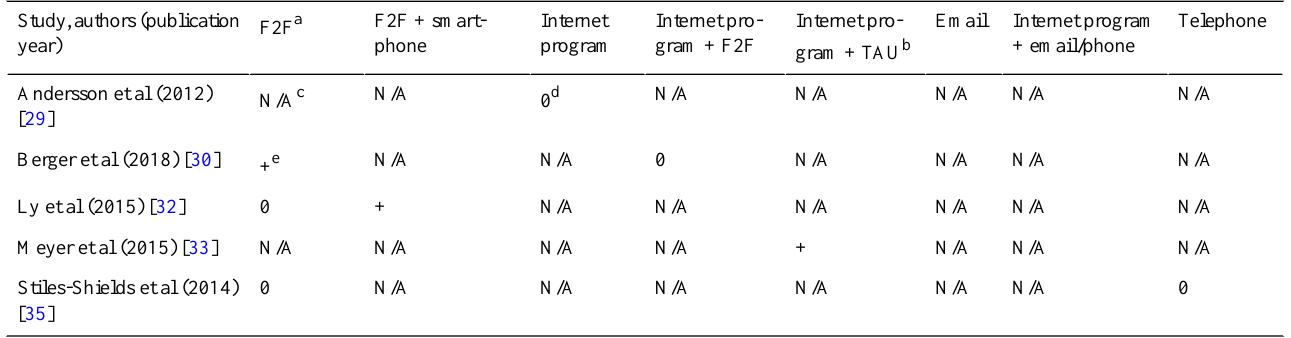
Table 5. Relationship between patients’therapeutic alliance ratings and treatment